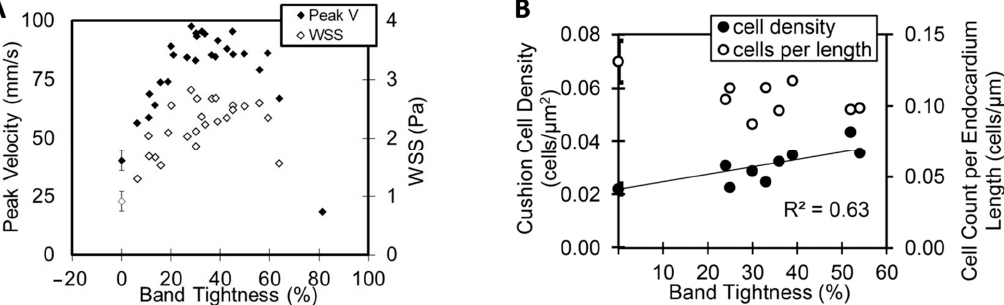
Figure 7. Outflow tract banding (OTB) intervention increases endocardial cushion mesenchymal cell counts in the heart OFT cushions. OTB was performed on chicken embryo hearts at HH18, and the OFT imaged in vivo before and after intervention; embryos were then collected at HH24 (after 24 h of OTB) and their hearts imaged. ( A ) Peak (maximum) blood flow velocity measured in vivo in the OFT 2 h after OTB, and estimated WSS on cushions, as a function of surgical suture (band) tightness, measured as a percent reduction in maximum OFT diameter due to the band. ( B ) Quantification of OFT endocardial cushion cell density and number of cells per unit endocardium length as a function of band tightness at HH24 after 24 h of OTB. A 0% band tightness corresponds to the control group. Adapted and reproduced from [27,84], respectively, under Creative Common License.